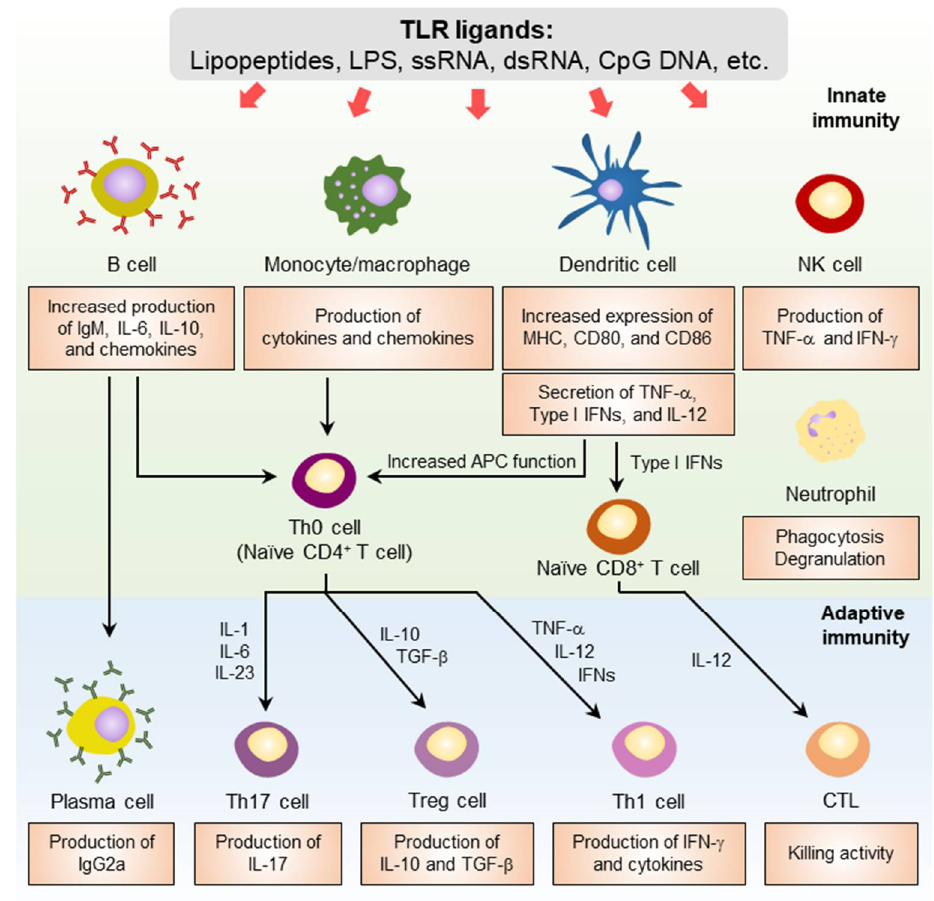
Figure 3. Immune responses elicited by TLR activations. TLR ligands directly activate APCs, such as monocytes/macrophages, DCs, and B cells. The surface expression of maturation markers and costimulatory molecules, including CD80, CD86, and MHC-II are increased in DCs and macrophages. The production of proinflammatory cytokines by activated APCs such as IL-1, IL-12, and type I IFNs promote naïve CD4 + T-cell differentiation to Th1, Th17, and Treg subsets. NK cells and CTLs are also activated, secreting IFN-γ and increasing killing activity, respectively. Moreover, B-cell activation by TLR ligands increases the production of IgM, IL-6, IL-10, and chemokines. Then the B cells differentiate to plasma cells, which increases their antigen-specific IgG production. APC, antigen- presenting cells; DC, dendritic cell; CTL, cytotoxic T lymphocyte; MHC, major histocompatibility complex; TNF, tumor necrosis factor; IL,